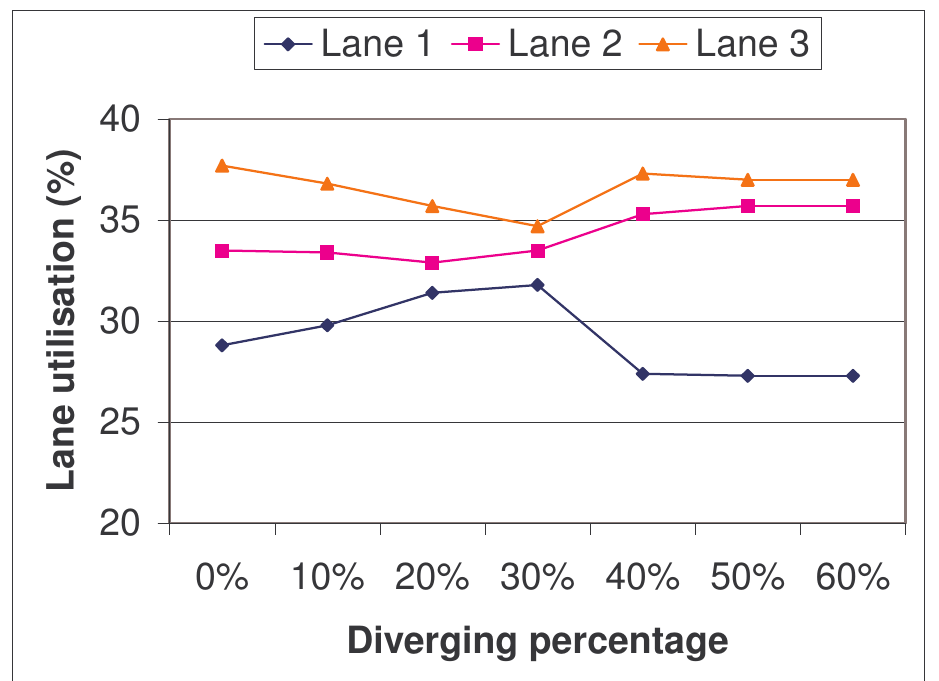
Figure 8. Lane utilisation 500m before the Taper diverge For the Parallel layout, the throughput remained high for the full range of diverging flows, with the most equal lane distribution at 50% diverging. The results showed that the presence of an auxiliary lane provided extra capacity at the junction (even if not fully reflected in